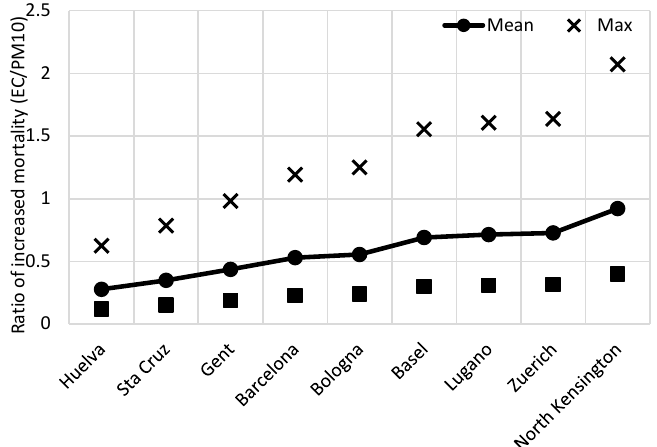
Figure 2. The ratio of relative increase in all-cause mortality associated with short-term exposure to measured levels of PM 10 vs. exposure to our calculated concentrations of EC, derived from measured concentrations at some urban background locations in Europe. The EC content is assumed to be 77% of BC (see text).